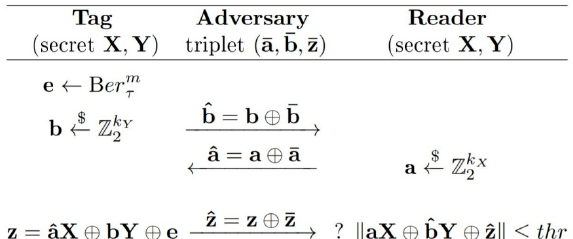
Figure 3. Man-in-the-middle OOV attack against the HB# and Random-HB# authentication protocols [13].